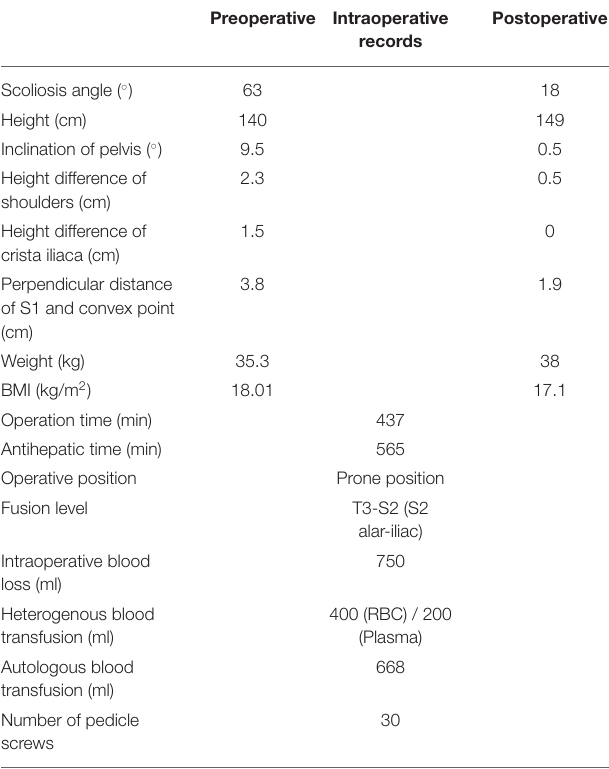
TABLE 1 | The clinical data and outcome about the orthopedic